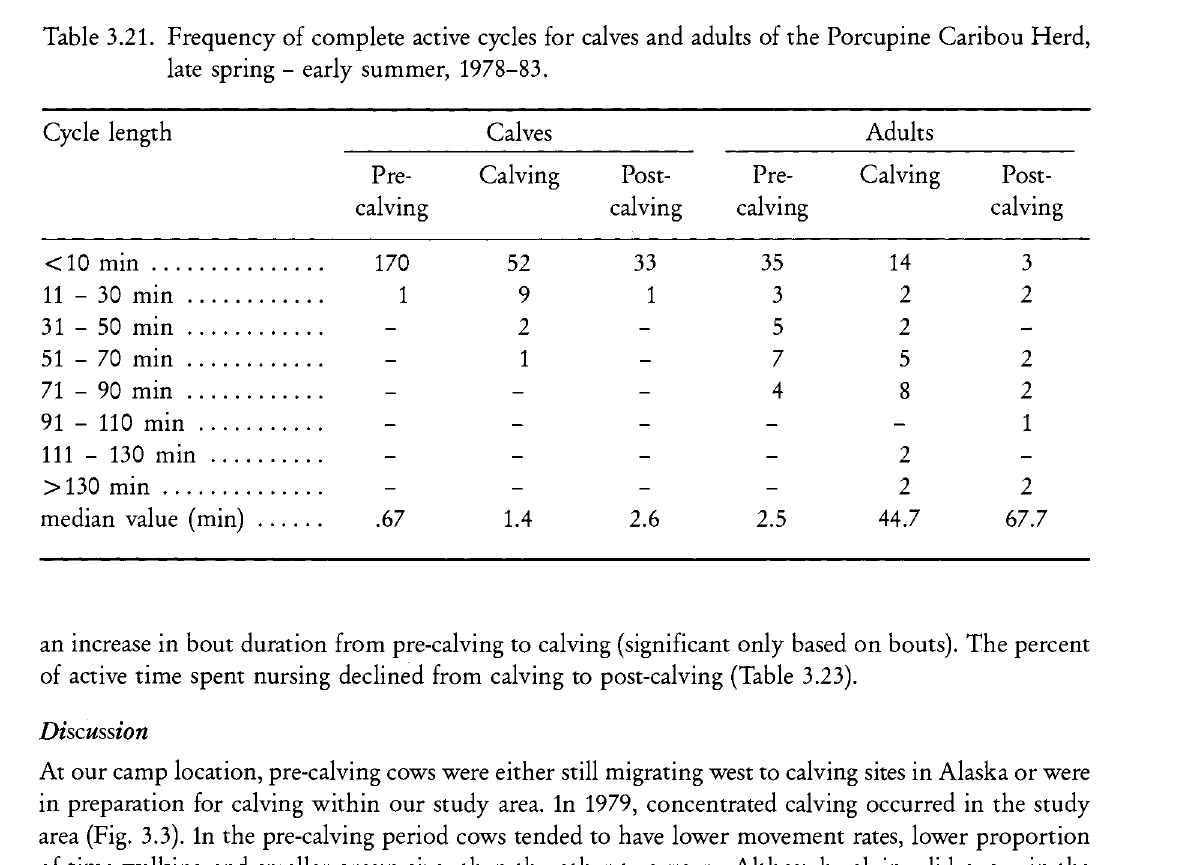
Table 3.22. Frequency of complete bedded cycles for calves and adults of the Porcupine Caribou Herd, late spring - early summer,